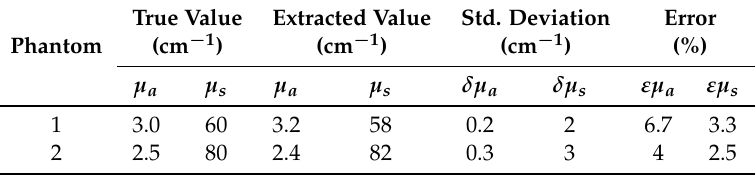
Table 5. Simultaneous reconstruction of absorption and scattering coefficients of the top layer from experimental SRR data with prior knowledge of both the optical properties of bottom